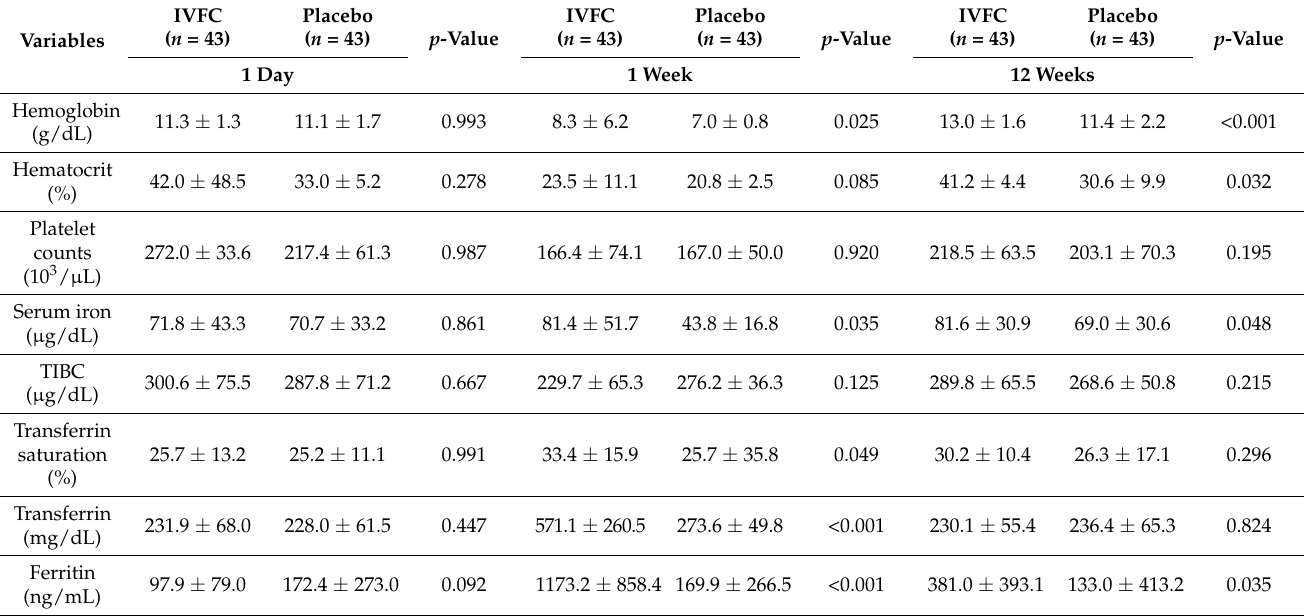
Table 2. Comparison of hematologic